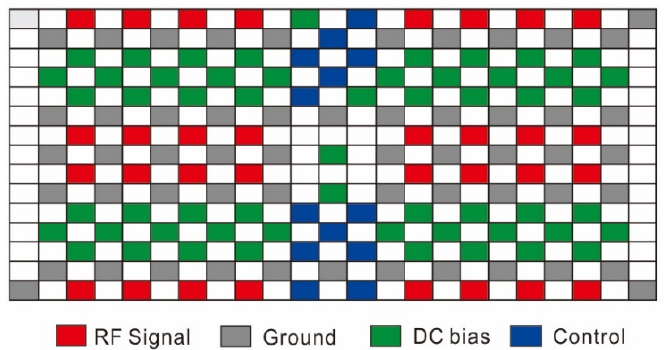
Figure 1. Ball pad map of the SoC under test with the chip size of 3.3 x 5.6 mm 2 .